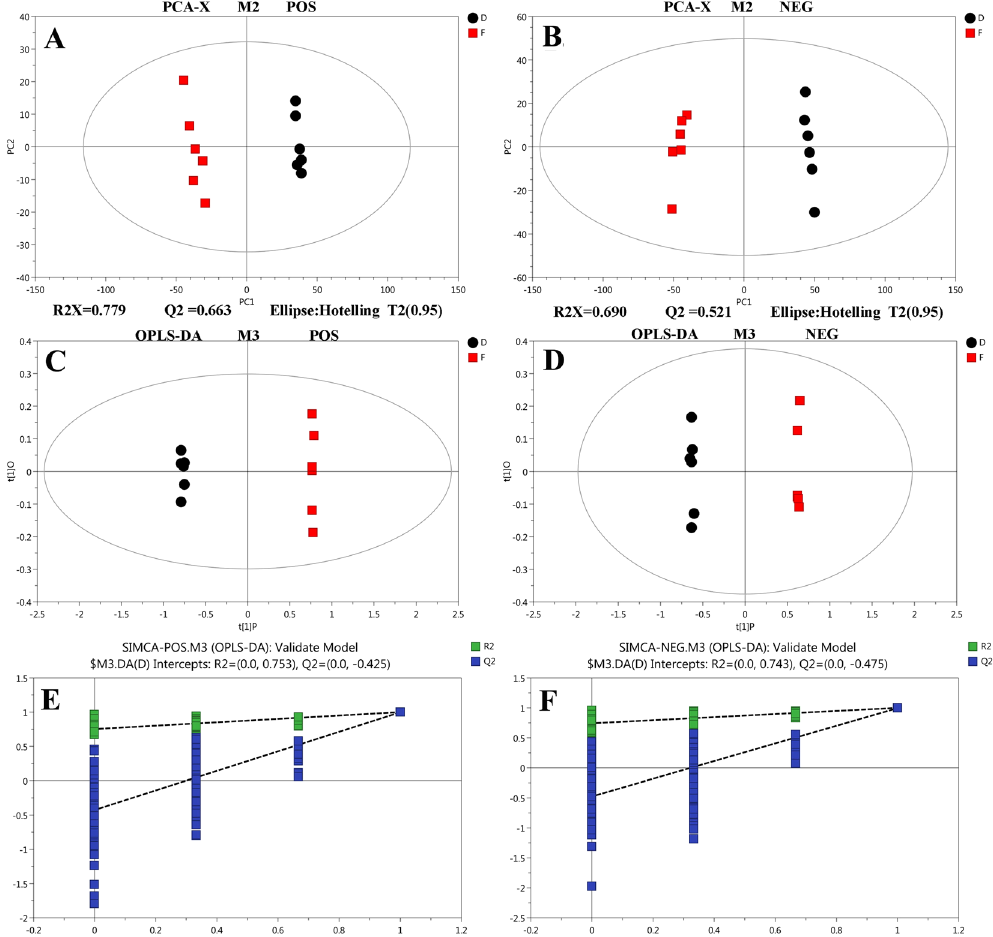
Figure 1. Score plot of the PCA ( A , B ) and OPLS-DA ( C , D ) models applied to parasitized and control aphids (POS and NEG). ( A , B ) Score plot of PCA model obtained from D and F (POS and NEG). ( C , D ) Score plot of OPLS-DA model obtained from D and F (POS and NEG). a ( E , F ) Score plot of OPLS-DA model obtained from D and F (POS and NEG). a Two hundred permutations were performed, and the resulting R2 and Q2 values were plotted. Green square, R2; Blue square, Q2. The green line represents the regression line for R2 and the blue line for Q2.